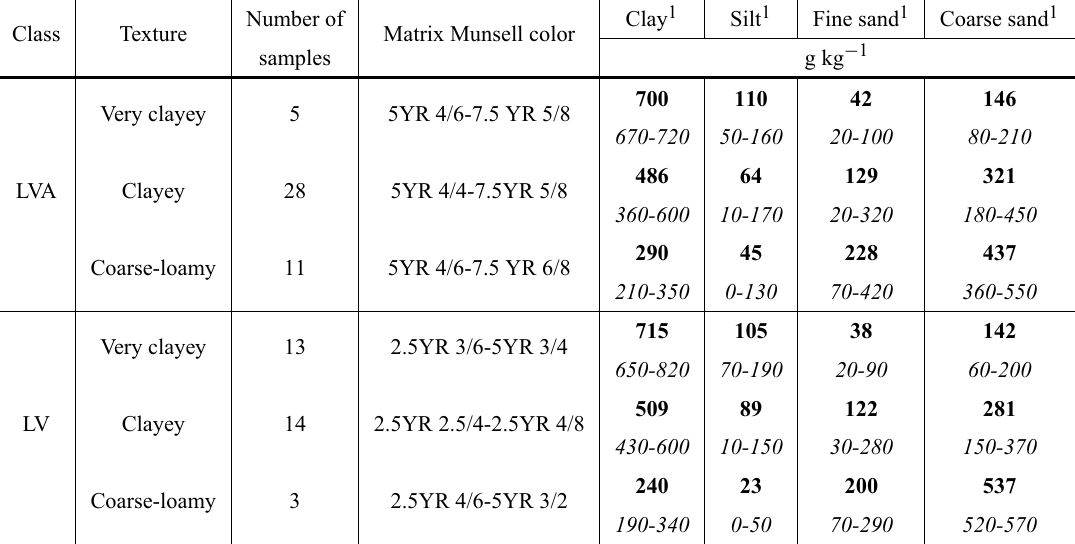
Class, texture, number of samples per group, matrix Munsell color and particle size distribution of Latossolos under pasture in the Brazilian Cerrado region.